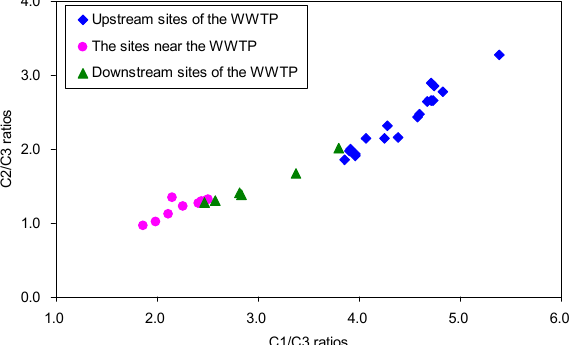
Figure 4. A plot of the C2/C3 ratios against the C1/C3 ratios for the discrimination of the sampling sites (Site 17 is